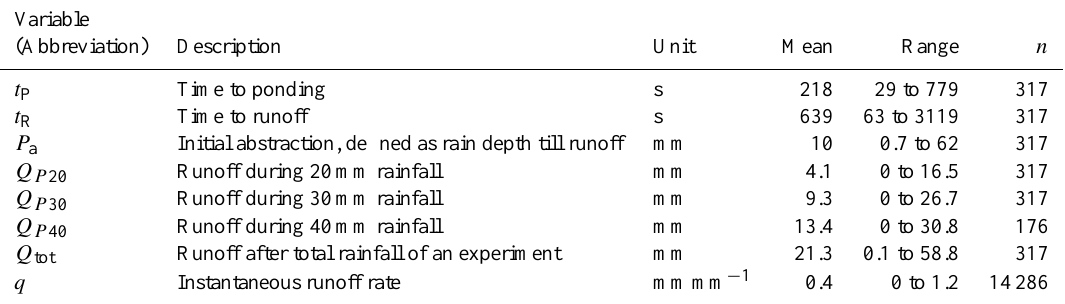
Table 2. Runoff variables from the 317 rainfall simulations used for statistical analysis and model development; the number of available data n varies according to the availability of the dependent